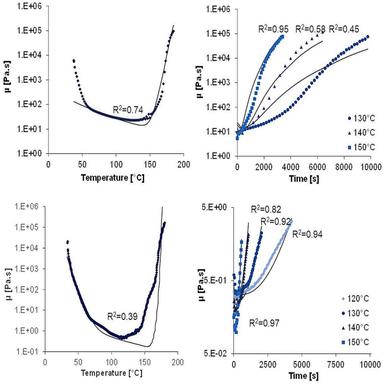
Viscosity under dynamic at 2 ◦C/min for both RS-3C and RS-3 (left top and bottom, respectively) and isothermal conditions for both RS-3C and RS-3 (right top and bottom respectively). The model fit is shown with the solid line. (For interpretation of the references to colour in this figure legend, the reader is referred to the web version of this article.)